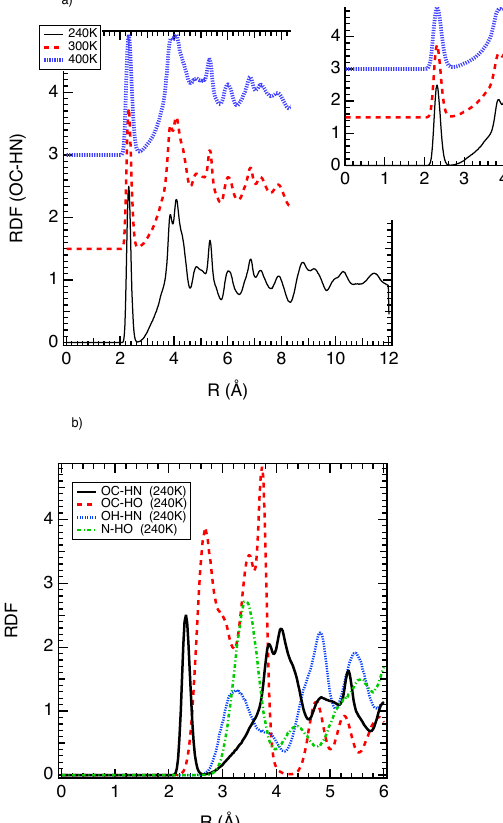
Figure 4. ( a ) Radial distribution functions between OC and HN (see Figure 2 for labels definition) at three temperatures. In the inset on top right an enlargement for the short distances was provided; ( b ) Radial distribution functions between OC and HN, OC and HO, OH and HN and N and HO at 240